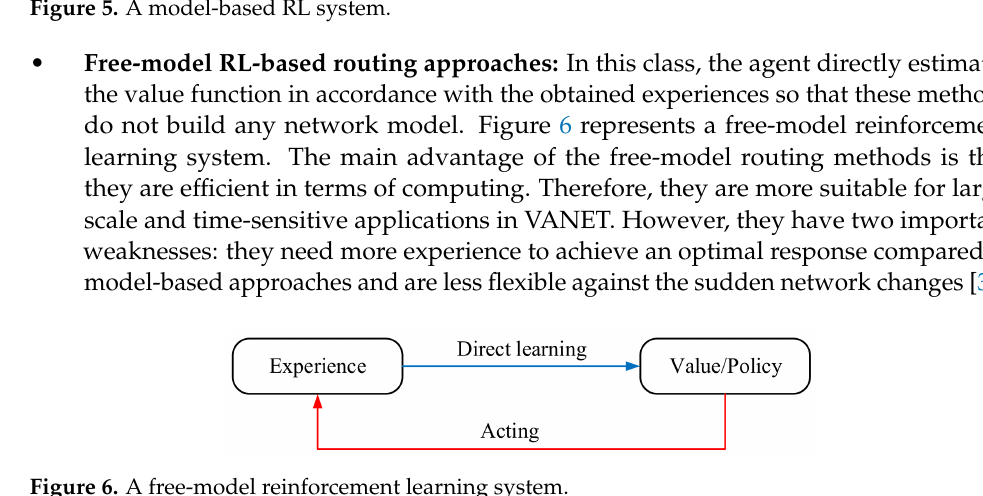
Figure 6. A free-model reinforcement learning system. Table 4. Comparison of model-based and free-model routing